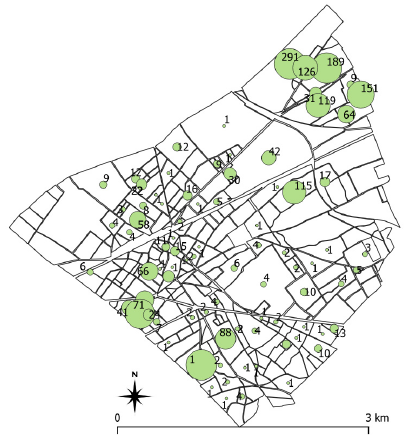
Figure 9. Distribution of the Algerian Muslims population in the ”ˆılots” of Nanterre.